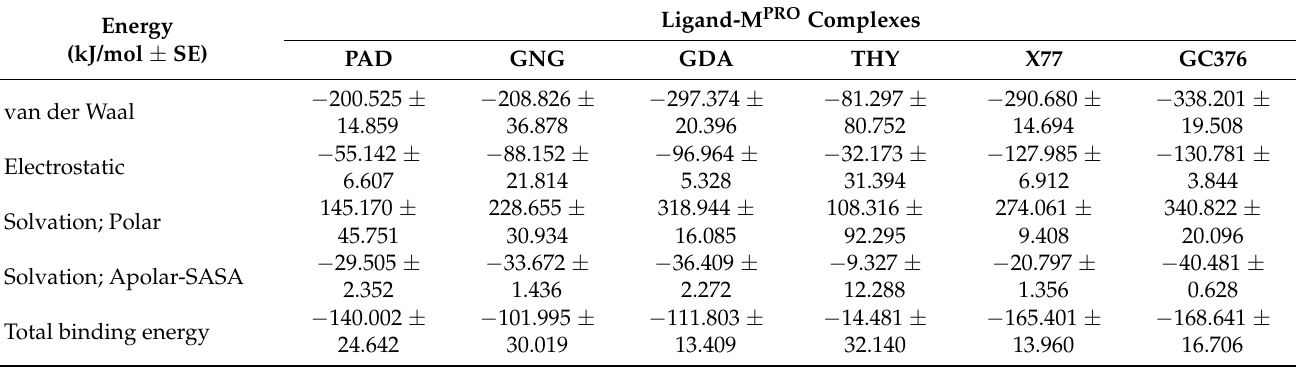
Table 5. Binding-free energies and dissected contribution energy terms of the ligand-M PRO complexes.